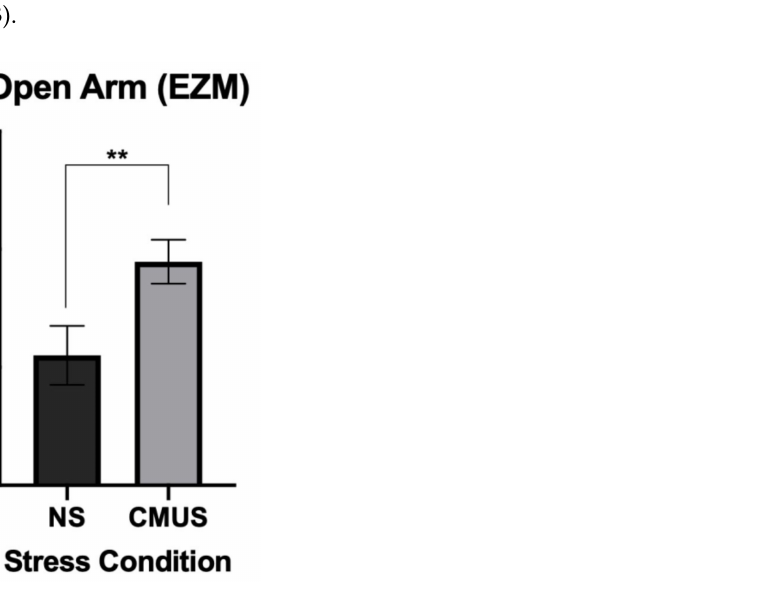
Figure 5. Percent time spent in the open arms of the elevated zero maze (EZM). Mice undergoing CMUS spent significantly more time in the open arms of the EZM compared to those in the NS condition (** p <